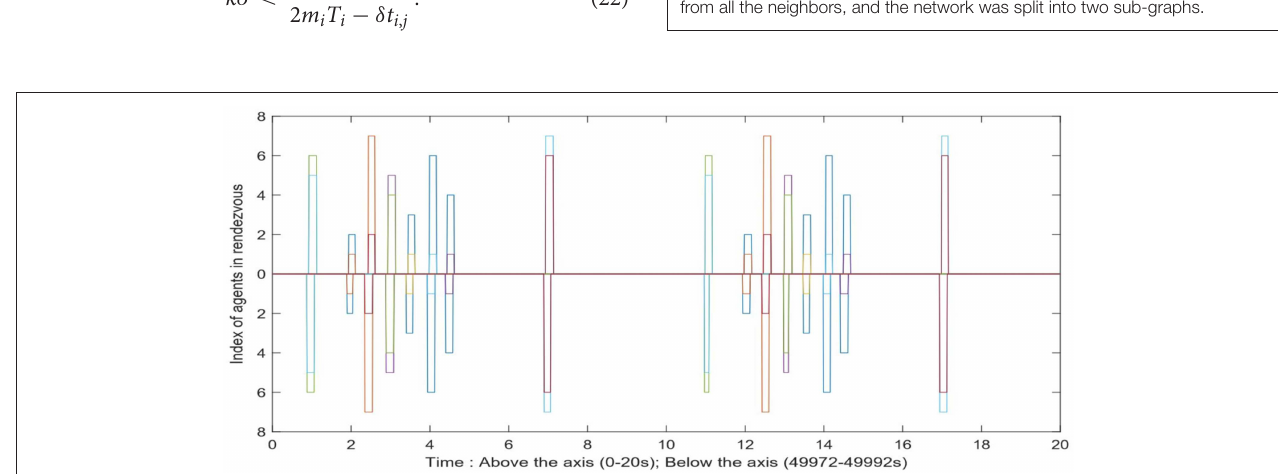
Frontiers in Robotics and AI |